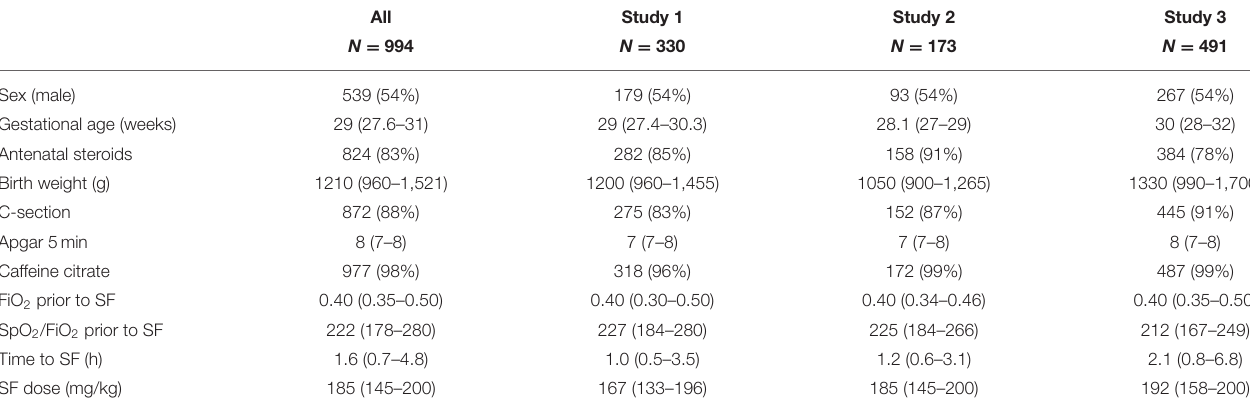
TABLE 2 | Clinical characteristics of the pooled study cohort ( N = 994).